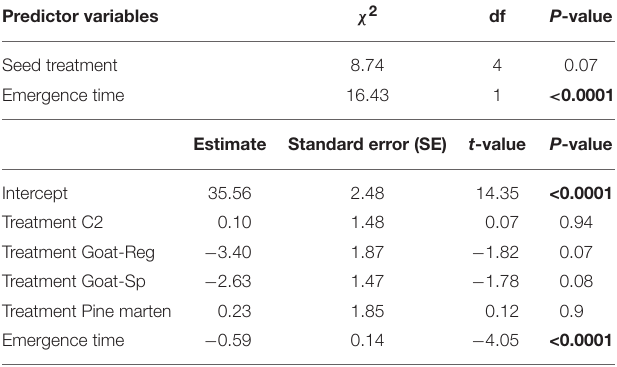
TABLE 3 | Main results of the linear mixed model testing the effects of seed treatment (C1 or “control seeds with pulp”, C2 or “manually-depulped control seeds”, Goat-Reg or seeds regurgitated by goat, Goat-Sp or seeds spit out by goat, and Pine marten or pine marten-ingested seeds) and emergence time (predictor variables) on seedling length for the first leaf (response